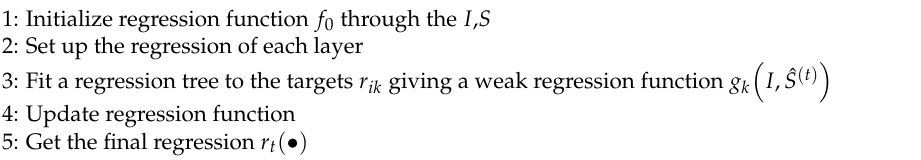
Algorithm 1. The ERT algorithm is used to form the initial position S passes through all the trees and mean shapes plus the ∆ S of the passed leaf nodes to obtain the final key point position of the